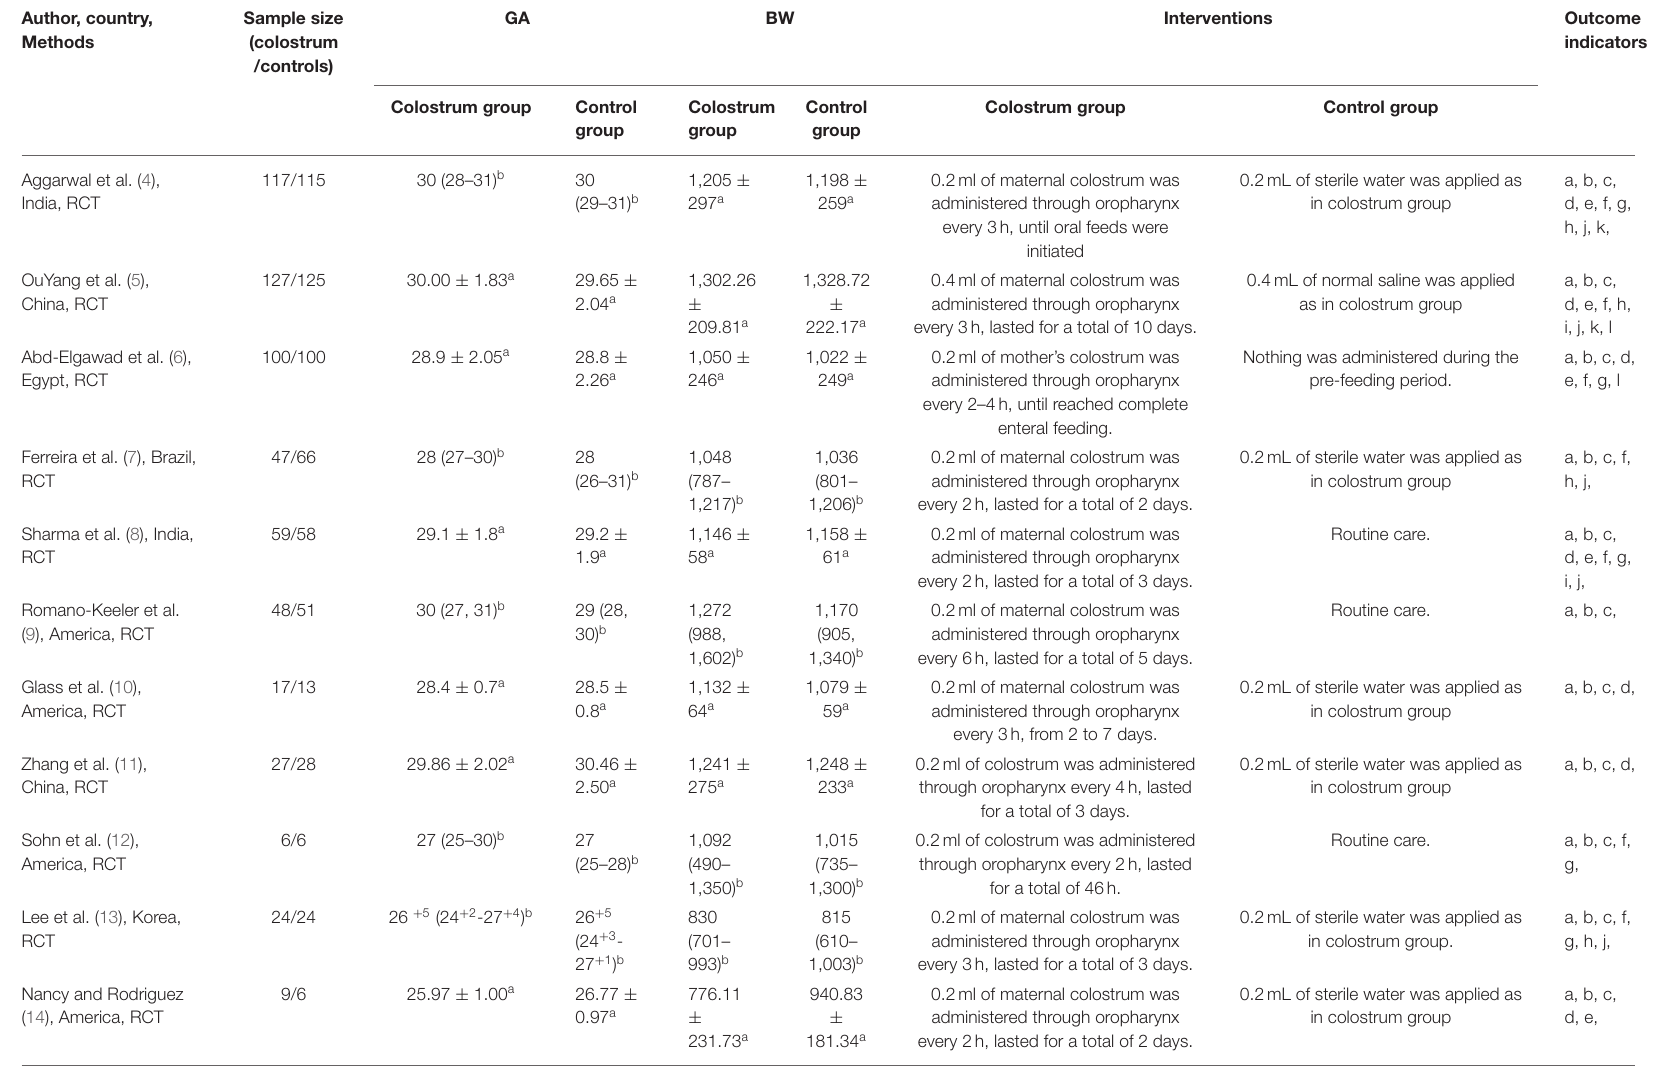
TABLE 1 | General characteristics of included